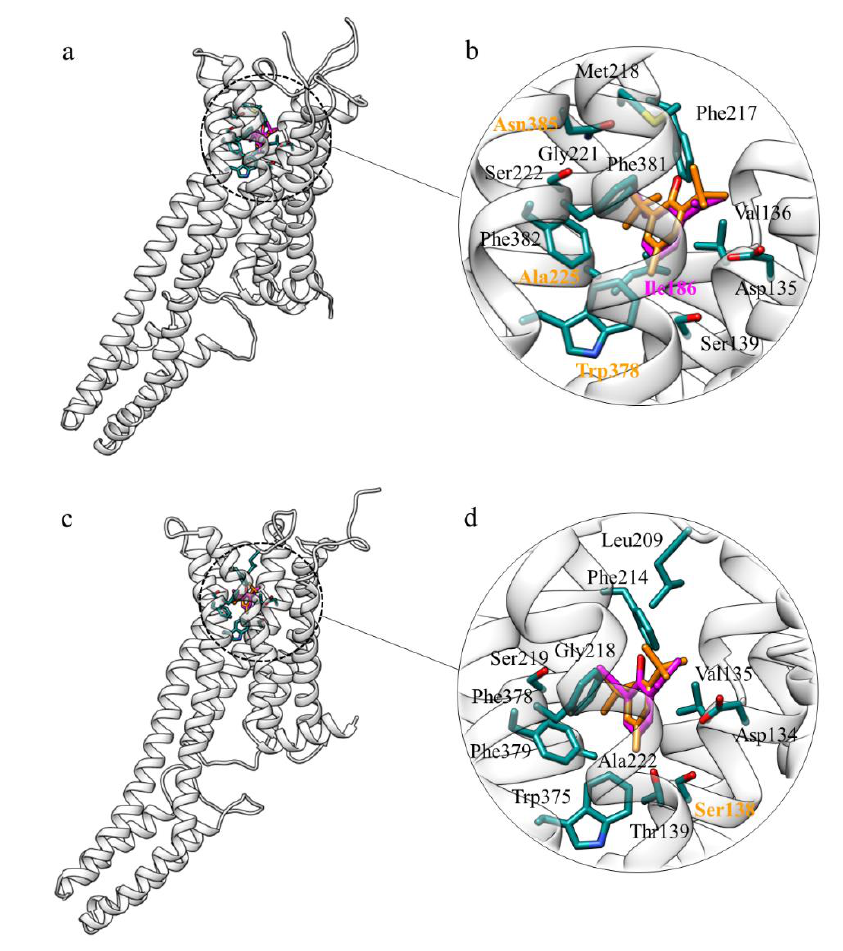
Figure 2. ( a ) Superimposition of the top-scoring poses for BHT (in orange) and PFL (in magenta) binding to 5-HT 2B R obtained by docking simulations; ( b ) detail of the hydrophobic interactions between 5-HT 2B R residues (coloured by atom type, carbon atoms in dark cyan) and the two ligands: BHT (in orange) and PFL (in magenta). The labels of the 5-HT 2B R residues interacting with both BHT and PFL are coloured in black. Asn385, Ala225, Trp378 (depicted in orange) interact only with BHT, while Ile186 (in magenta) only with PFL; ( c ) Superimposition of the top-scoring poses for BHT (in orange) and PFL (in magenta) binding to 5-HT 2C R; ( d ) detail of the hydrophobic interactions between 5-HT 2C R residues (coloured by atom type, carbon atoms in dark cyan, black labels) and the two molecules, BHT (in orange) and PFL (in magenta). Ser138 interacts only with BHT, while the other residues with both ligands.